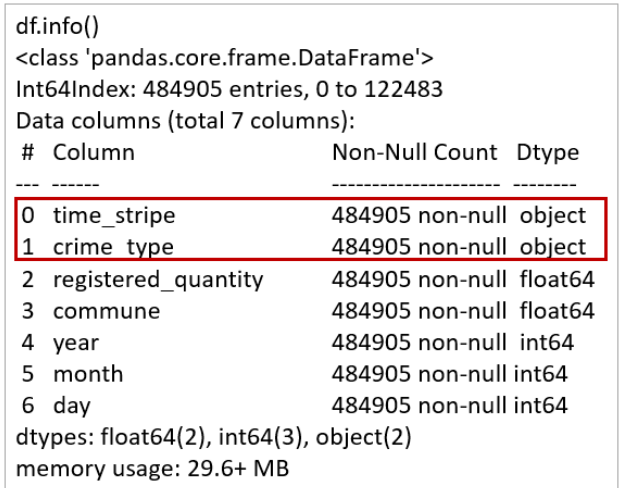
Figure A2. Result of the execution of df.info(). Source: Own elaboration.